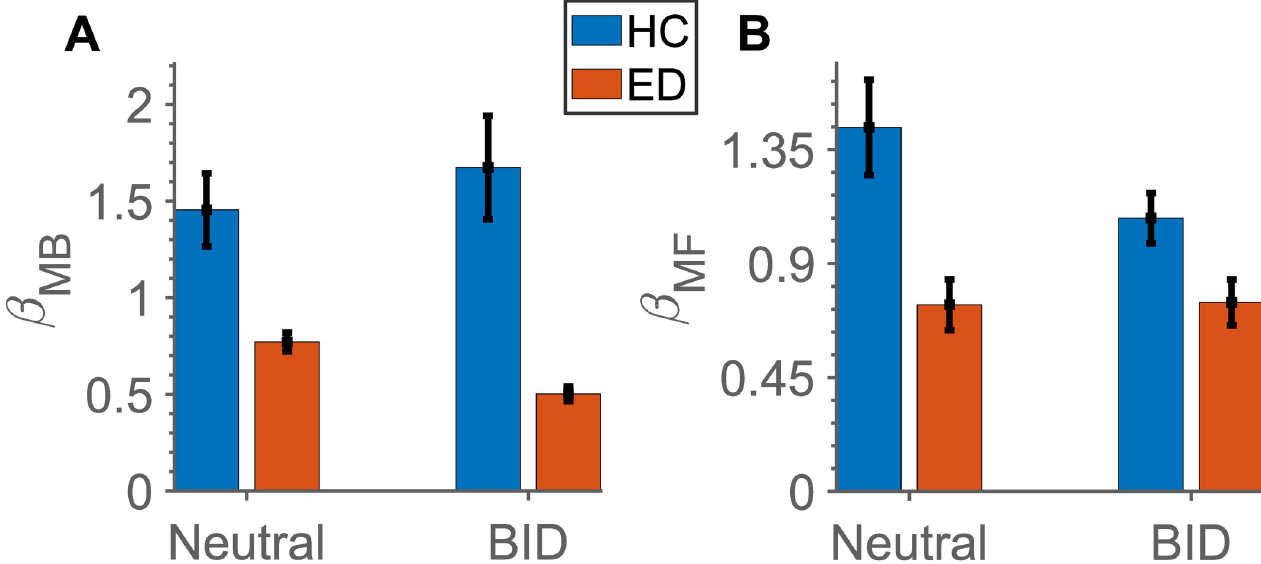
Fig 6. Estimated model parameters. Mean standard error (SE) of the estimated model parameters in HC (blue) and ED (red) during each condition (neutral and BID). (A) β MB , (B) β MF